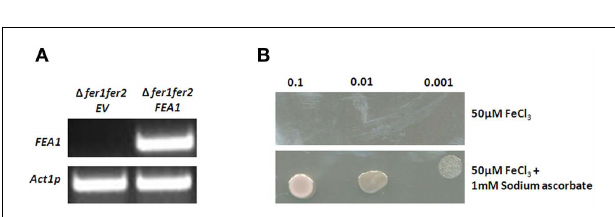
FIGURE 7 | FEA1 facilitates iron uptake in Arabidopsis at high pH. Wild-type and transgenic Arabidopsis plants were grown hydroponically on 0.072M Fe (Sprint 330) until day 48. (A) Image of wild-type (WT) and transgenic Arabidopsis plants grown at different pH levels (pH 5, 7, and 8.5).